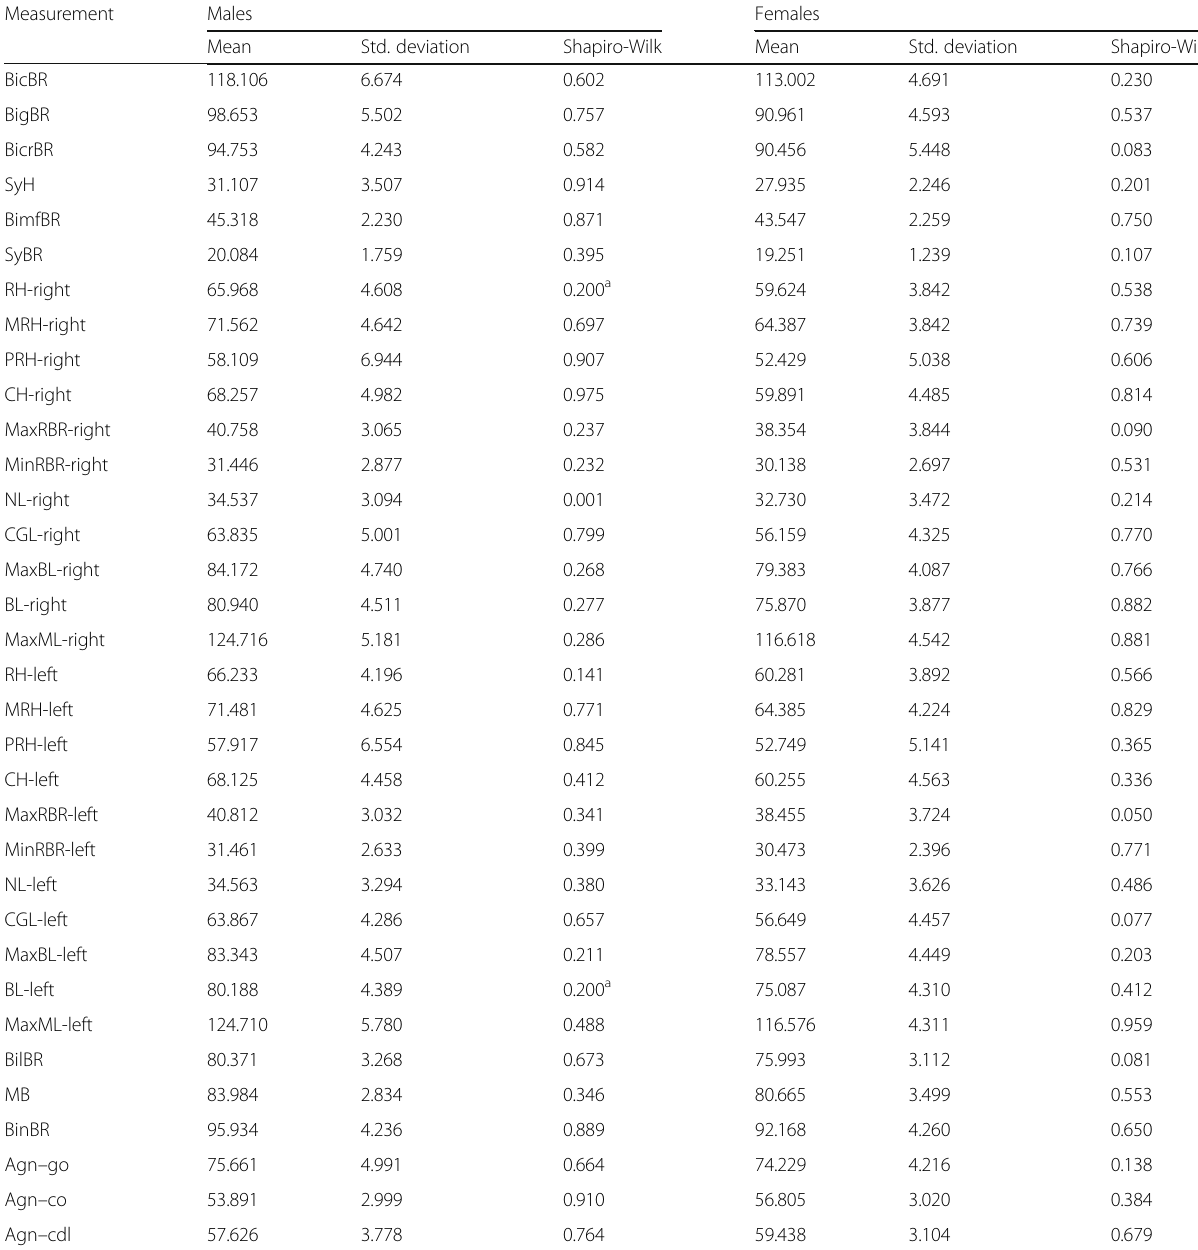
Table 3 Descriptive statistics for each measurement variable